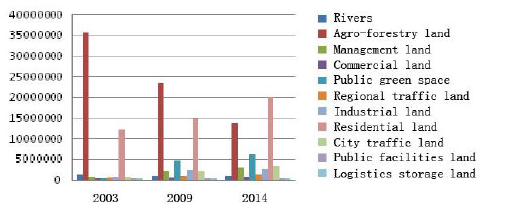
Figure 3. Land Use Structure of Guyuan City, 2003-2014